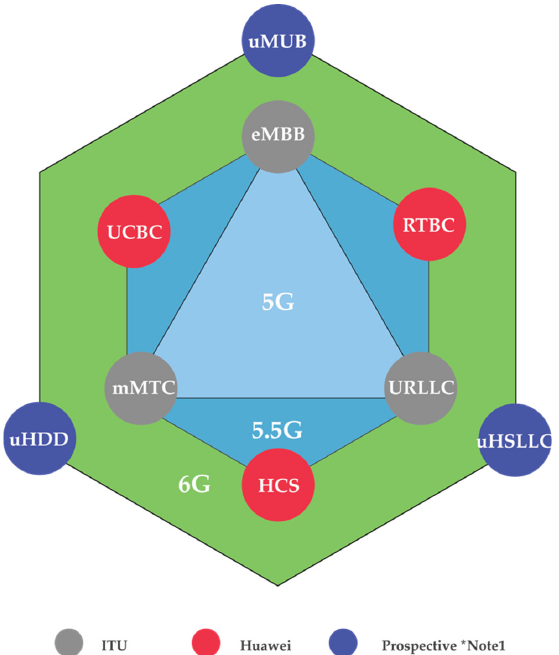
Figure 1. Comparisons of use cases for 5G and 6G systems. * Note 1: Ref. [40] .